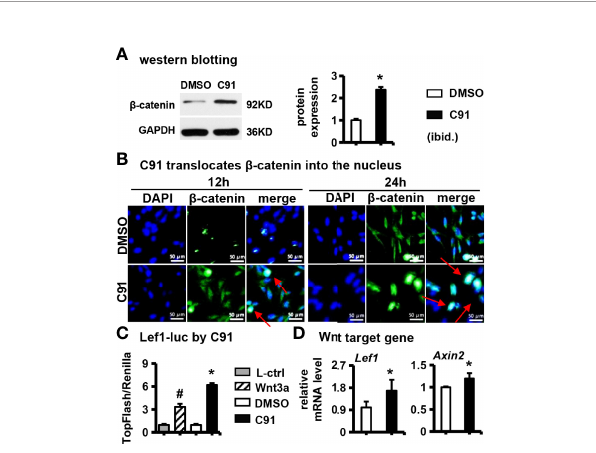
FIGURE 3 | Effects of inhibition of Wnt/ b -catenin signaling pathway on ST2 cell differentiation. Triptonide (Tript) is a Wnt signaling inhibitor. ST2 cells were treated with C91 and Tript (10nM) for 3 days, and the samples were collected for AP staining analysis (A) and AP biochemical quantitative analysis (B) . Positive cells, scale bar = 100 m m. (C, F) qRT-PCR detection of osteogenic target genes and Wnt target gene mRNA expression levels. (D) ST2 cells were treated with Tript (10 nM) and C91 for 14 days, and the osteogenic induction medium was changed every two days in between. Alizarin red S staining was used to detect mineralized nodules. The lower image is a 10× enlargement of the upper image. Red arrows are mineralized nodules, scale bar = 50 m m. (E) is the quantitative analysis result of panel (D) Results are expressed as mean ± SD (n = 3 per group). * indicates P < 0.05, compared with the DMSO group. # indicates P <0.05, compared with the C91